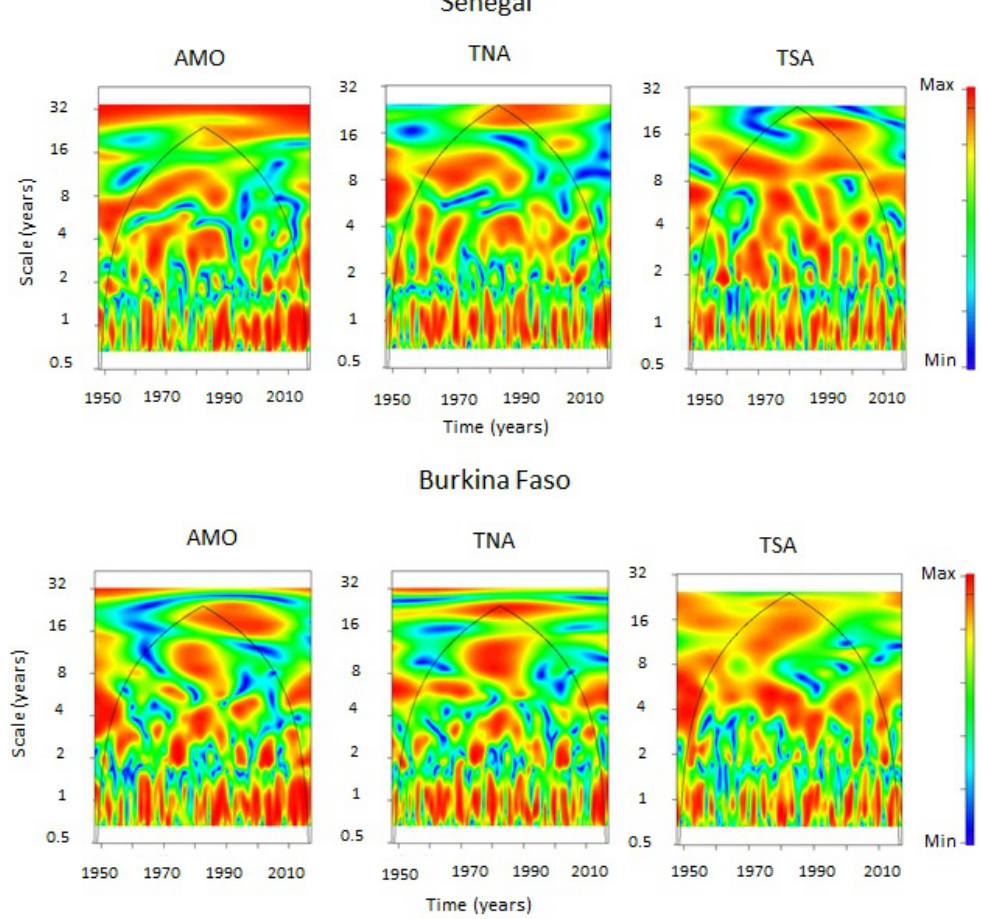
Figure 4. Wavelet coherence analysis between average monthly rain in Senegal and Burkina Faso (average of the different stations in each country) and climate indices: Atlantic multidecadal oscillation (AMO), Tropical Northern Atlantic Index (TNA), and Tropical Southern Atlantic Index (TSA).